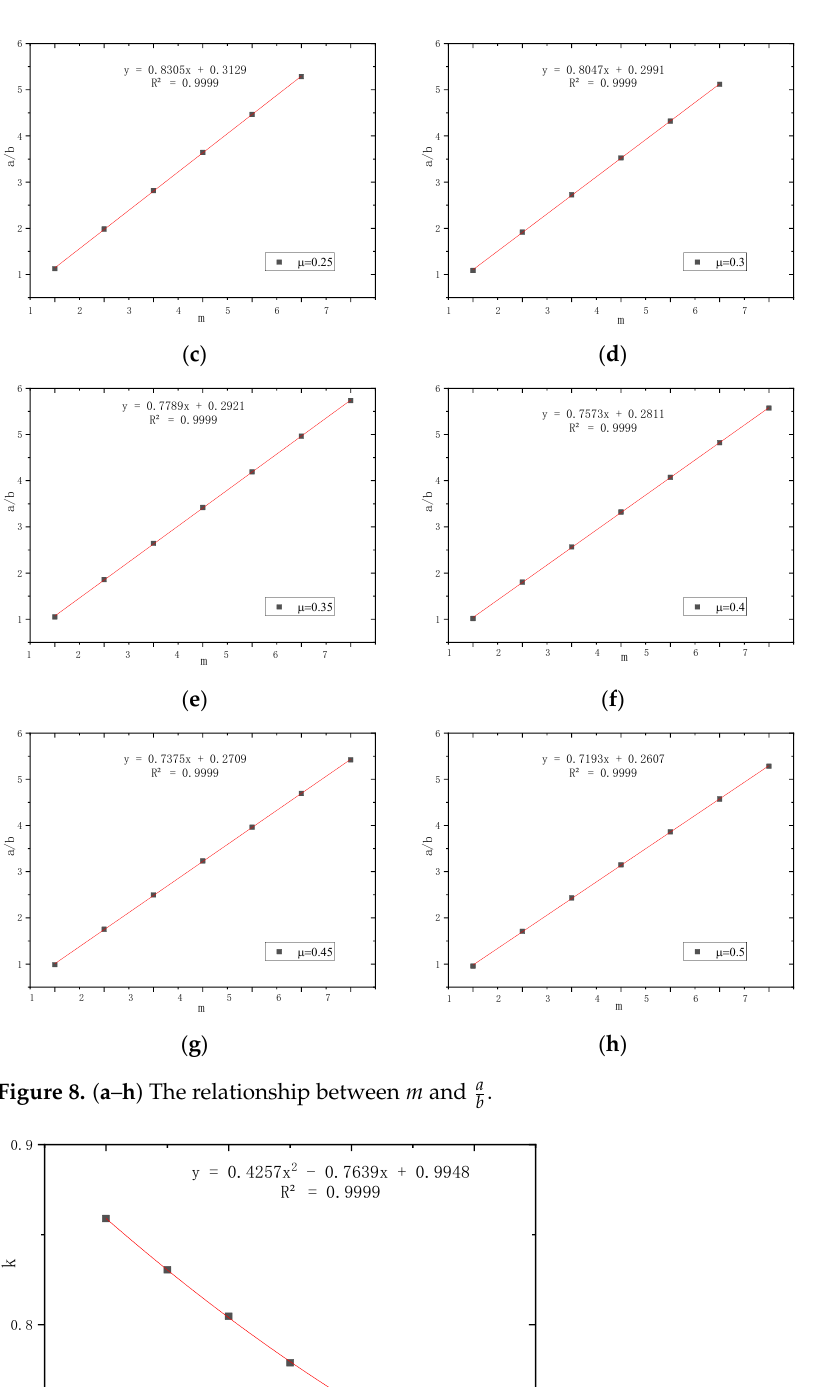
Figure 9. Relationship between the slope of the fitting curve and the Nominal Poisson’s